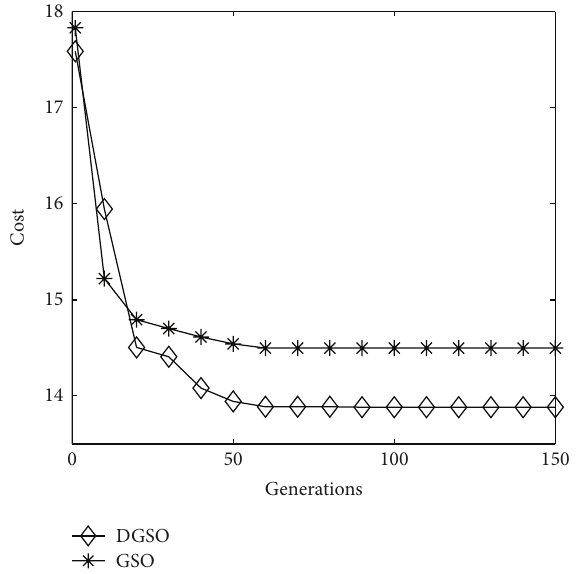
Figure 7: Performance index in successive generations ( 8 × 8 network).